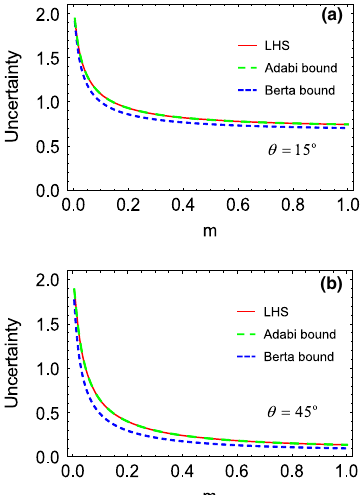
Fig. 6 The LHS, Adabi bound, and Berta bound with respect to the particlemass m ofthescalarfieldwhenconsideringtwocomplementary observables (σ x ,σ z ) . ε = ε max = ( 4 / m 2 − 1 )/ 2, σ = 2, (cid:14) = 2, and μ = μ = 0 . A B